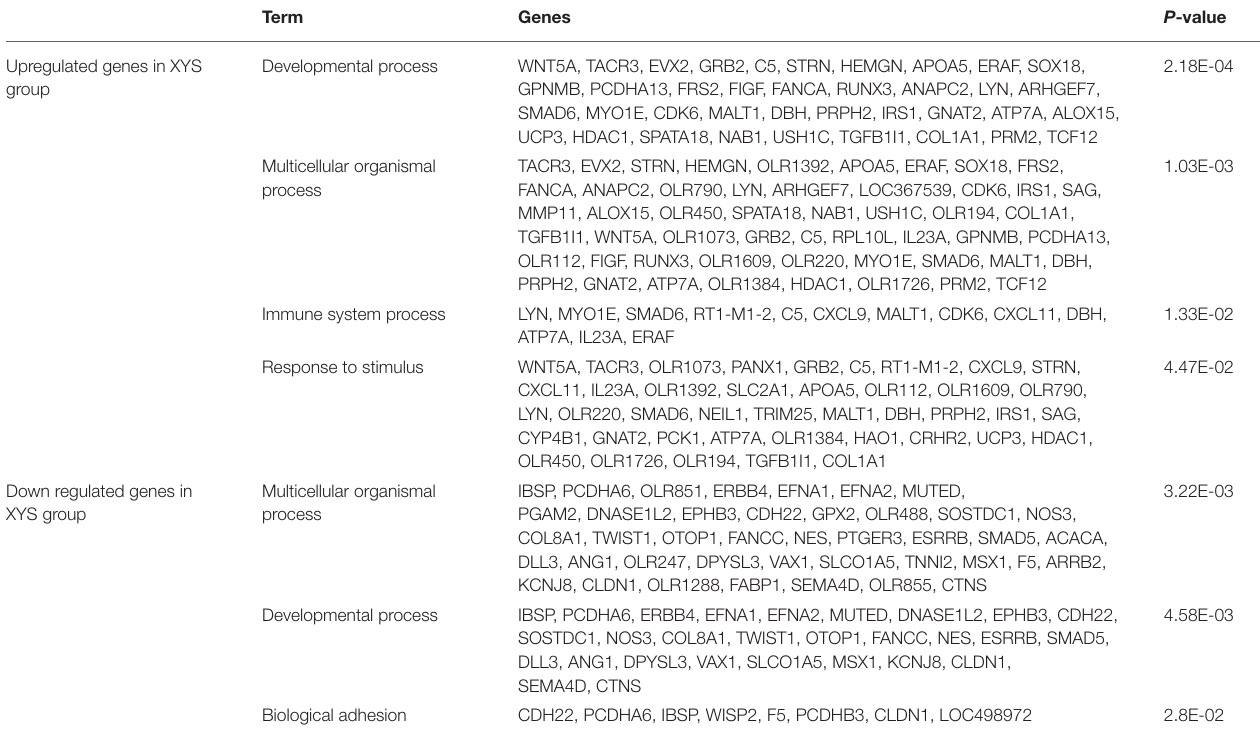
TABLE 2 | Classification of the upregulated and downregulated genes involved in the significant bioprocesses of the XYS group compared with the model group.